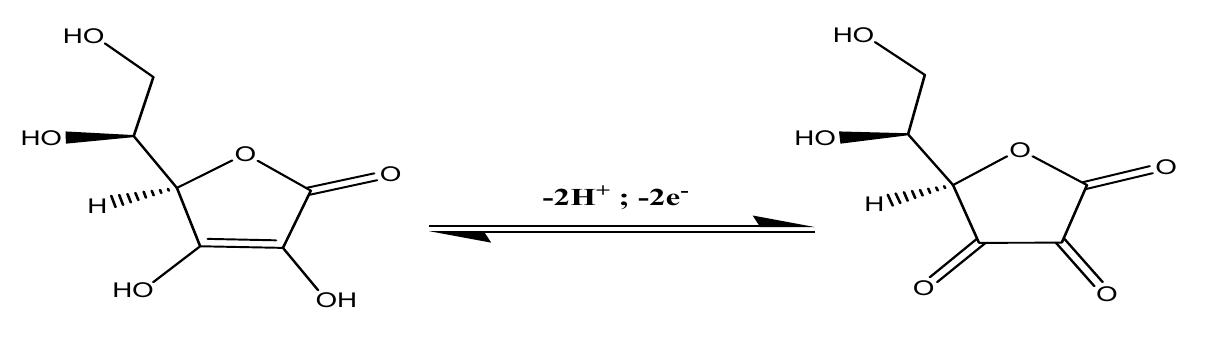
Scheme 1. AA redox mechanism pathway.